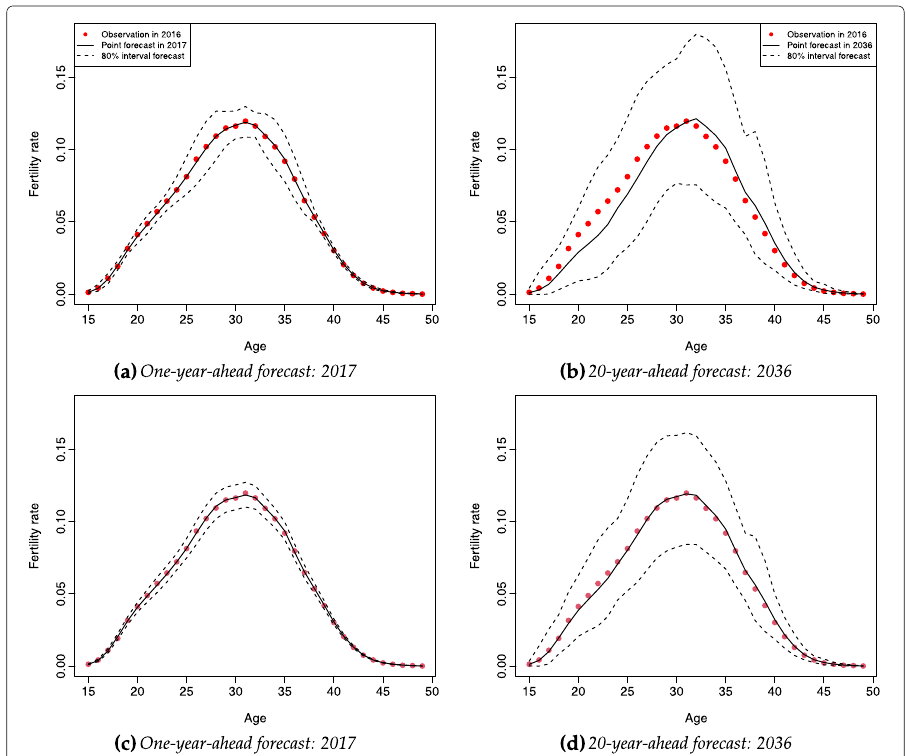
Fig. 4 Point and 80% interval forecasts of age-specific fertility rates in England and Wales, based on data for 1938 to 2016 using model averaging with frequentist weights (in the first row) and BIC weights (in the second